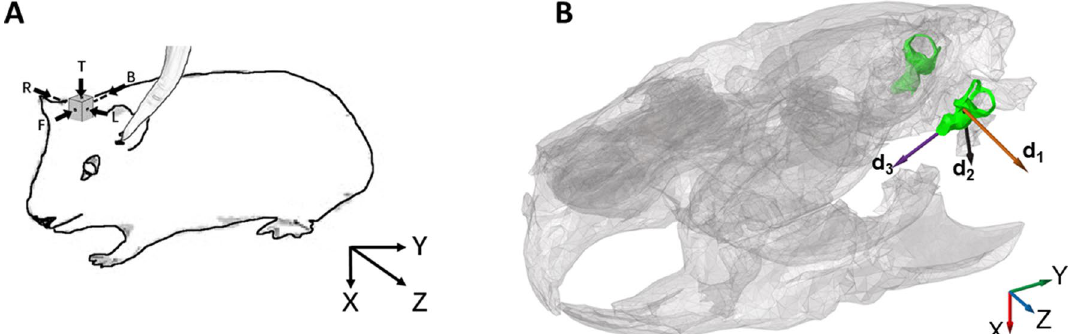
Figure 1. The guinea pig. ( A ) The BC transducer is attached to the brass cuboid and the tube for AC stimulation is placed at the ear canal opening. The coordinate system indicates the directions used for the vibration measurement with the laser Doppler vibrometer where x-direction is ventral, y-direction is posterior, and z-direction is left. ( B ) The skull bone of a guinea pig with the inner ears shown in green. The bone around the left cochlea has been removed for visibility purpose. The anatomical references for vectors d 1 , d 2 and d 3 are given in the text.